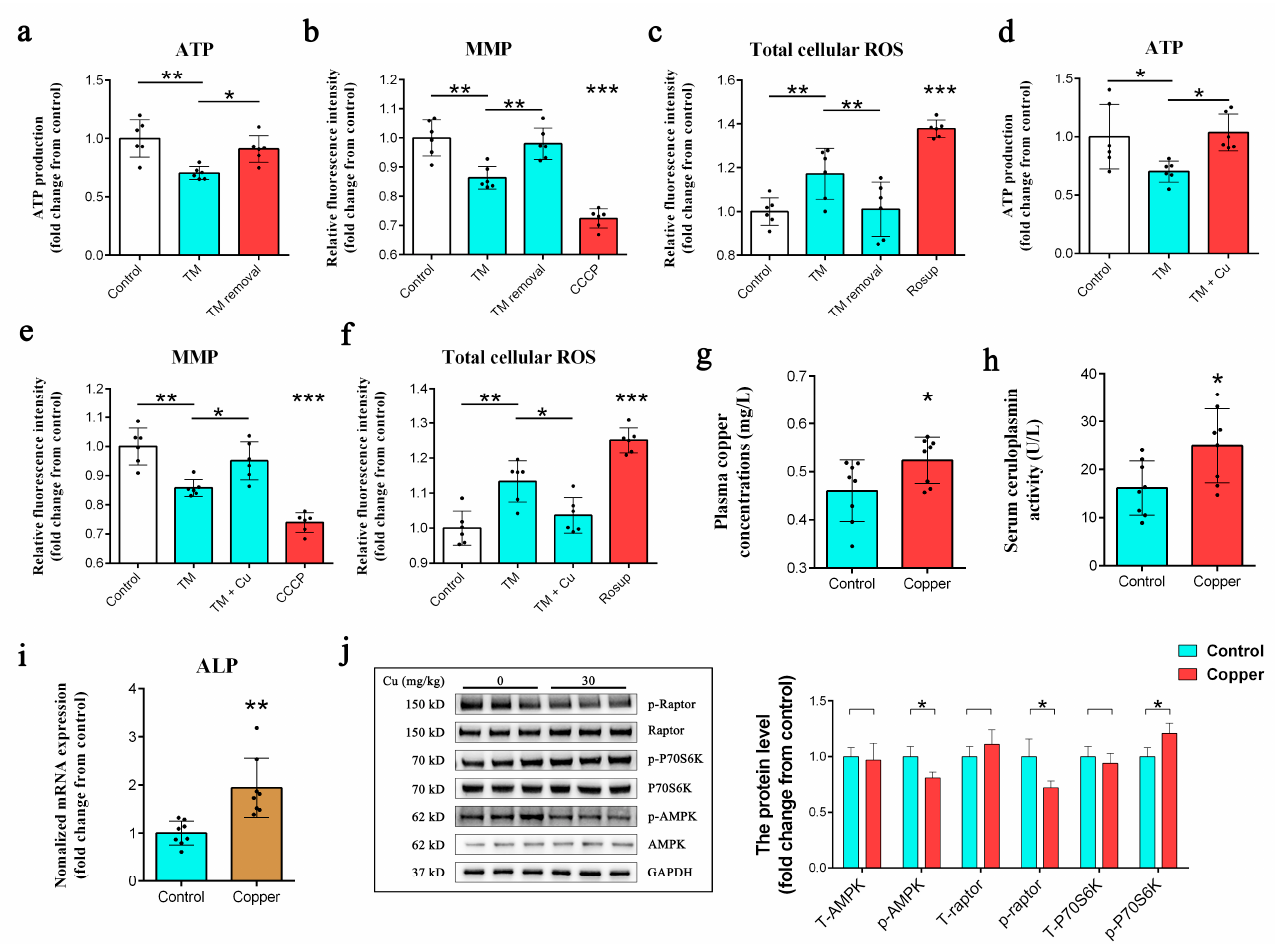
Figure 6. ( a ) Effect of TM removal (48 h of TM removal after 48 h of treatment with 5 µM TM) from treated DPCs on ATP production ( n = 6/group); * p < 0.05, ** p < 0.01. ( b ) Effect of TM removal (48 h of TM removal after 48 h of treatment with 5 µ M TM) from treated DPCs on MMP ( n =